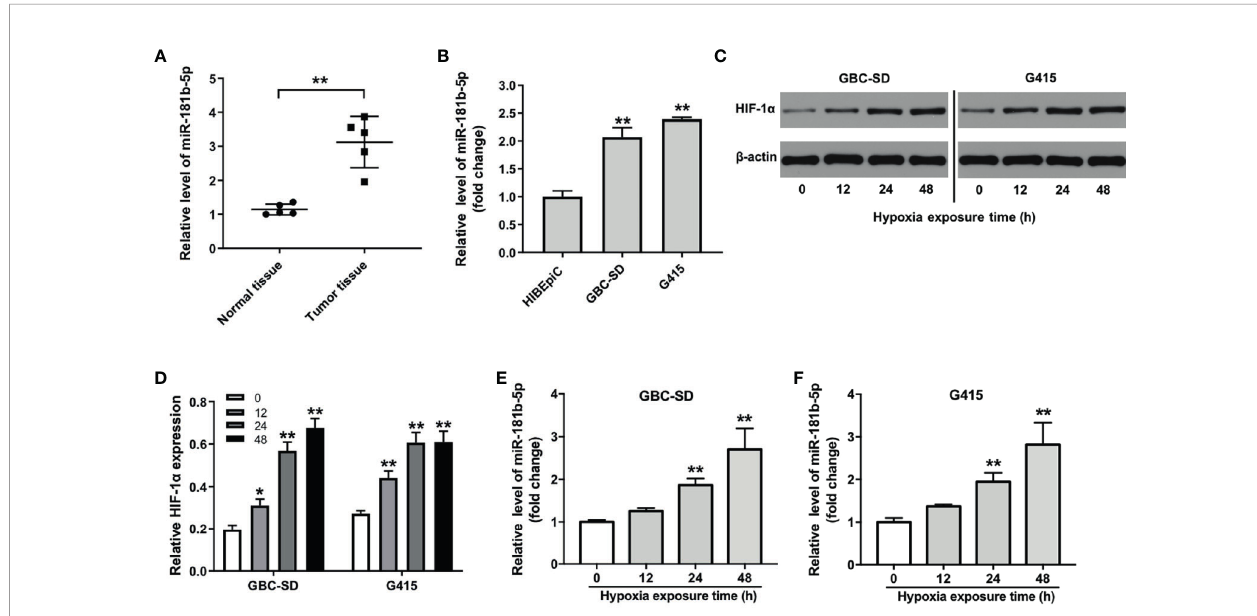
FIGURE 2 | The expression level of miR-181b-5p is upregulated in GBC. (A) PCR was performed to measure the level of miR-181b-5p in fi ve non-neoplastic gallbladder tissues (normal tissues) and fi ve gallbladder tumor tissues (tumor tissues). (B) RT-qPCR was performed to measure the level of miR-181b-5p in HIBEpiC, GBC-SD or G415 cells. (C, D) GBC-SD or G415 cells was exposed to hypoxia (a humidi fi ed atmosphere of 1% O 2 ) for 0, 12, 24, 48 h Western blot was performed to measure the expression of HIF-1 a in GBC-SD or G415 cells. (E, F) GBC-SD or G415 cells was exposed to hypoxia (a humidi fi ed atmosphere of 1% O 2 ) for 0, 12, 24, 48 h RT-qPCR was performed to measure the level of miR-181b-5p in GBC-SD or G415 cells. *P < 0.05, **P < 0.01 compared with control group, n =